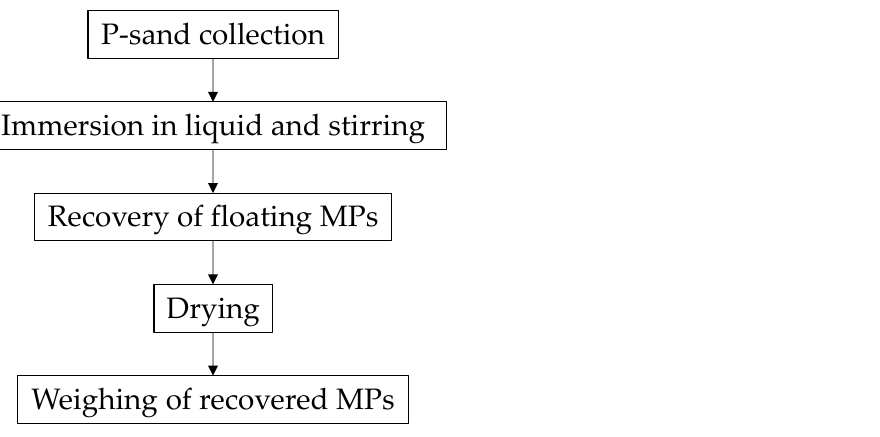
Figure 3. Measurement flow of MP content in P-sand proposed in this study.